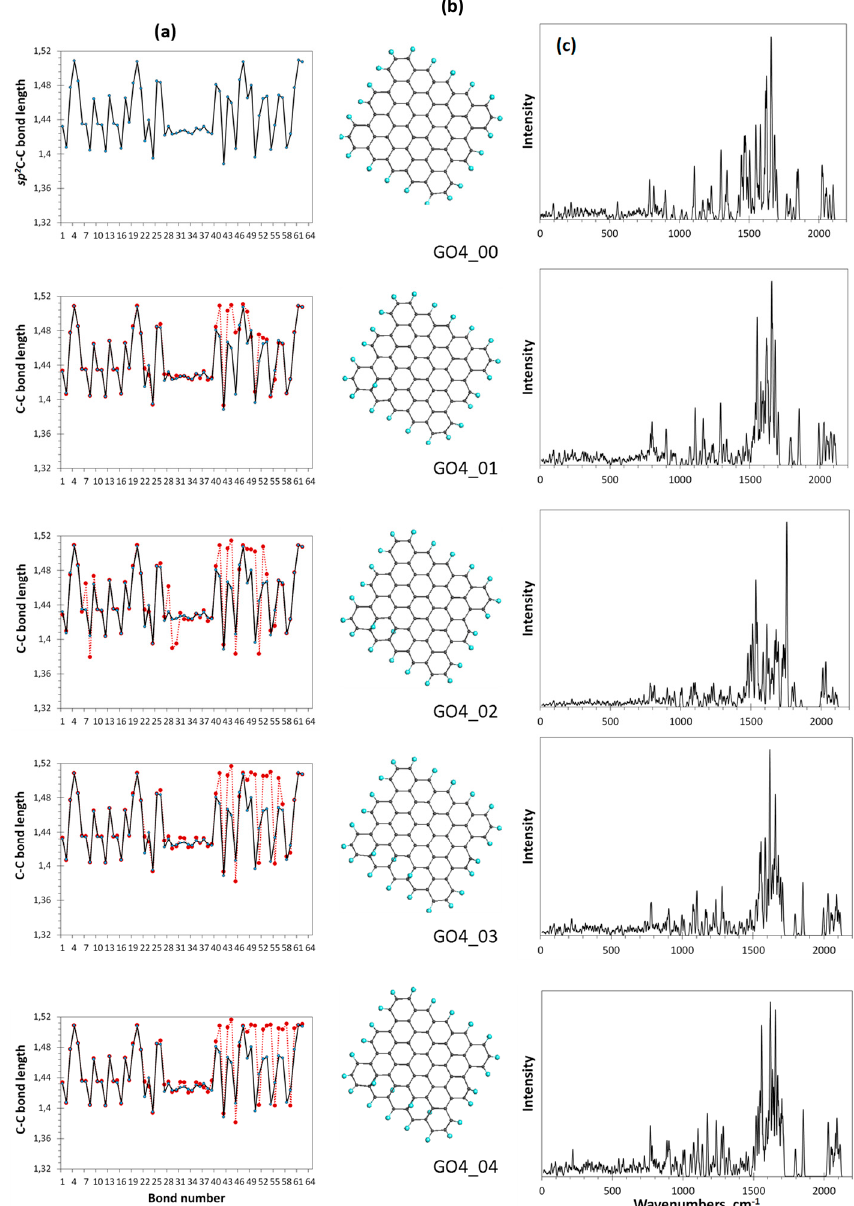
Figure 7. Monitoring of the sp 2 - to -sp 3 C-C covalent bond transformation at first steps of the oxidation of basal-plane carbon atoms of the reference GO4_00 TD. a. TD’s C-C bond length distributions (reference and step current presented with solid black and dotted red plottings, respectively). b.